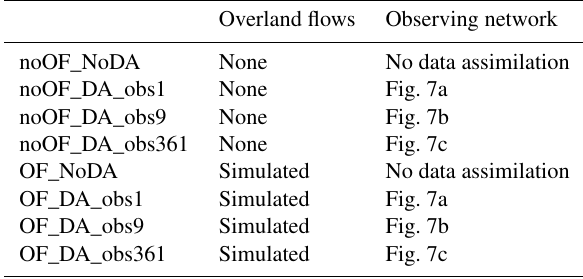
Table 2. Configuration of the data assimilation experiments in Sect.